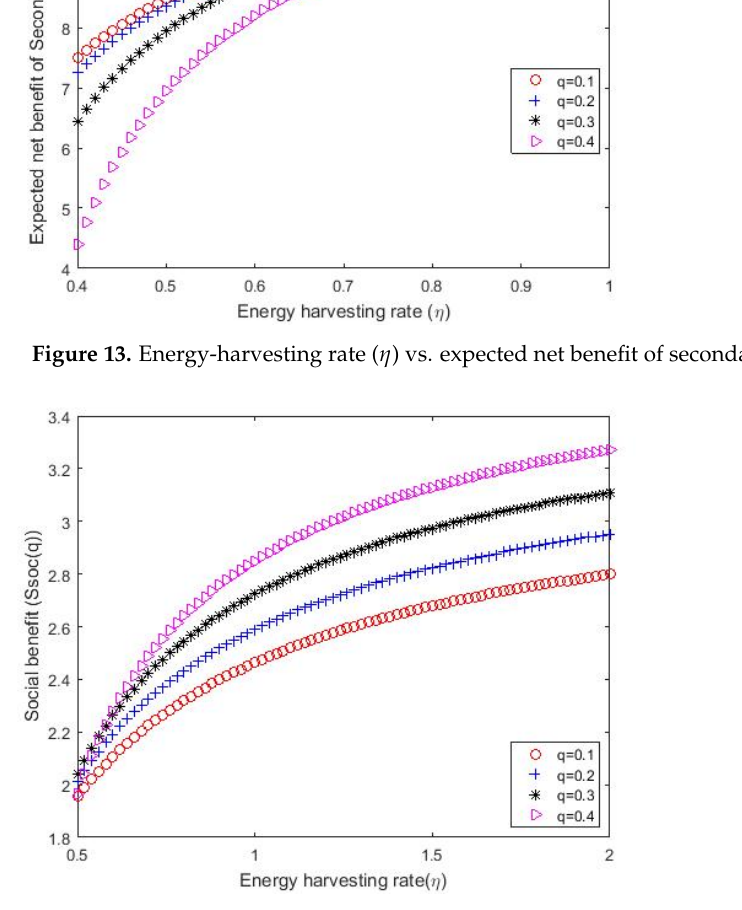
Figure 14. Energy-harvesting rate η vs. social